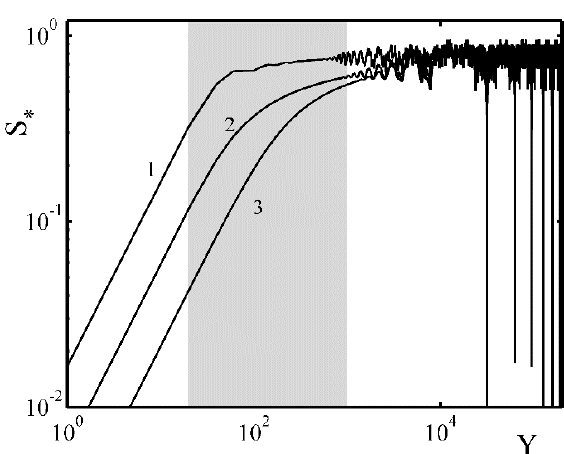
Figure 12: Normalized scintillation level versus parameter for different orientation angle .